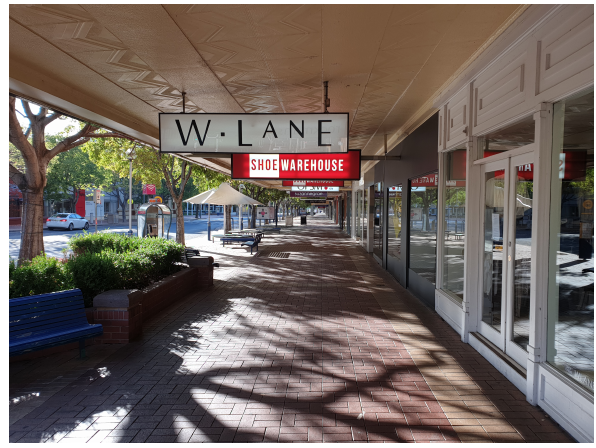
Figure 1: The effects of the lockdown on the main shopping street of a regional community (Albury, NSW, 18 April 2020)